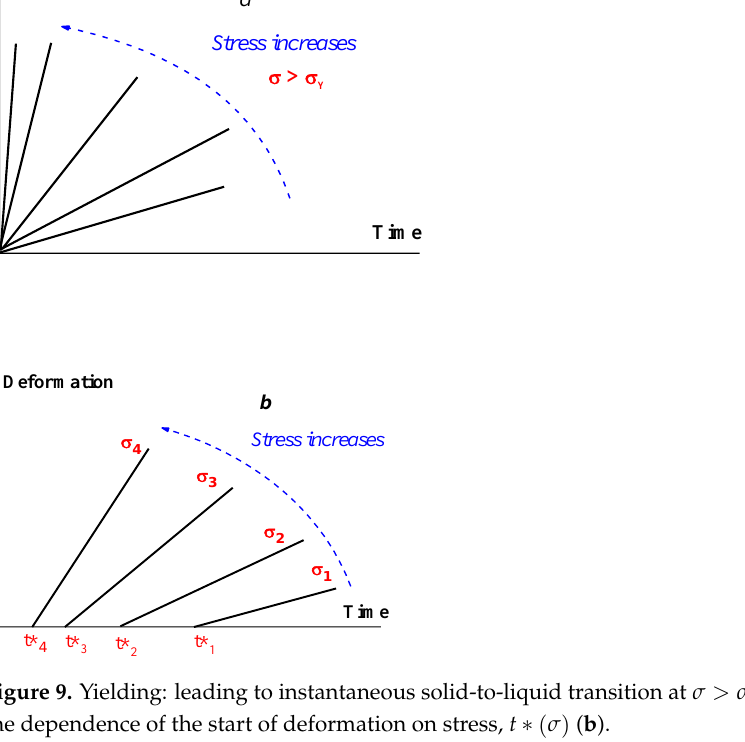
l og t [ s ] l og  [ P a* s ] Figure 11. Time effects in measuring a flow curve in the scanning mode. It is seen that the lower the shear rate, the longer the time it takes to reach a time- independent viscosity value. This might be treated as the limit of viscosity corresponding